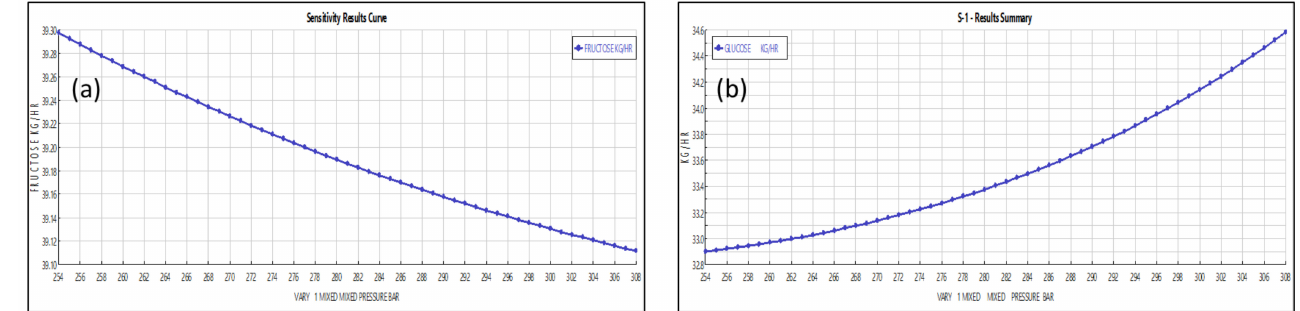
Figure 4. Effect of operating pressure on recovery of fruit sugars—( a ) Fructose and ( b )